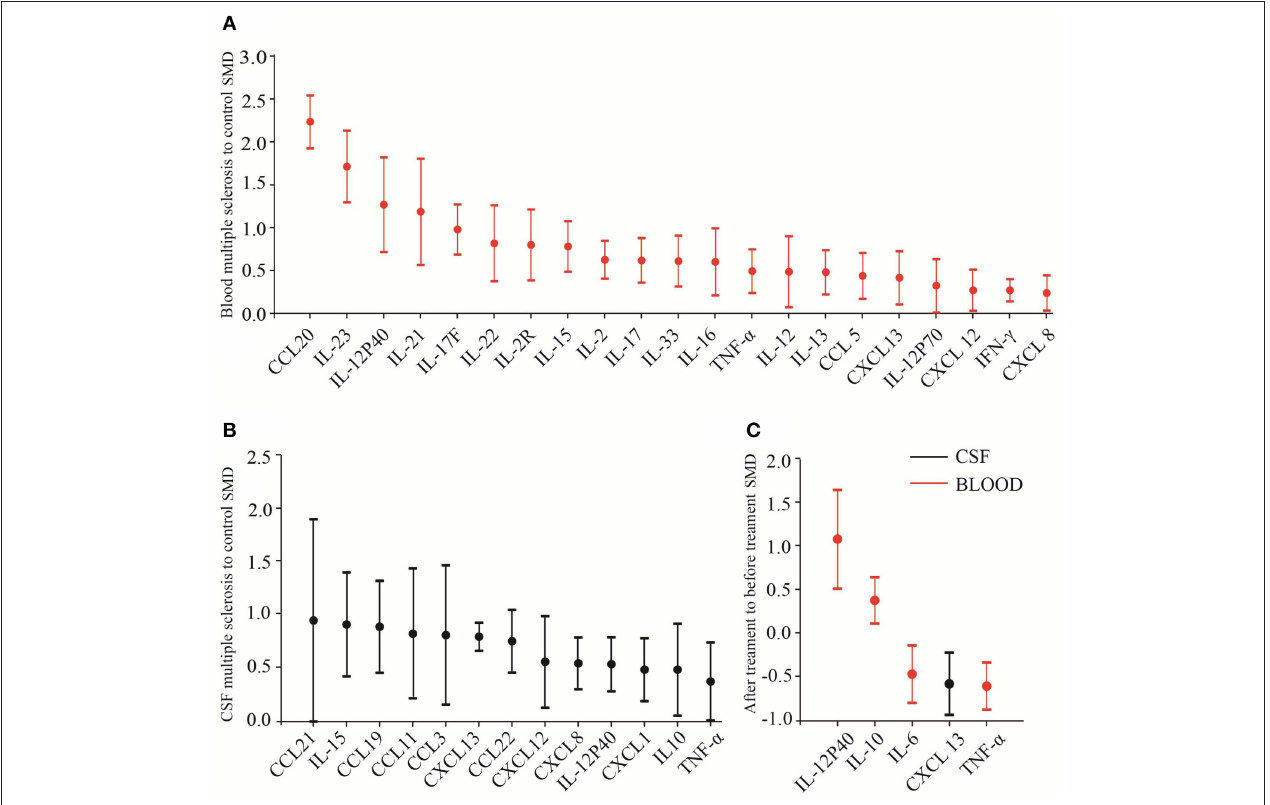
FIGURE 4 | Biomarker performance rating for multiple sclerosis. Head-to-head biomarker performance in blood (A) and in CSF (B) based on multiple sclerosis to control SMD. (C) Biomarker performance for drug